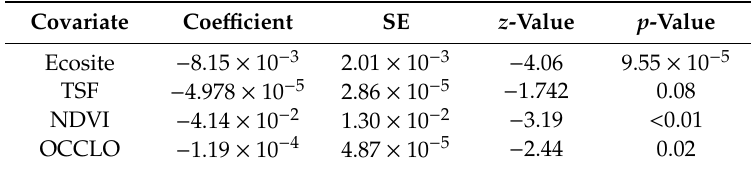
Table A6. Model summary for the model used to create the canopy closure layer for modelling lichen presence and abundance. TSF = time-since-fire, NDVI = normalized di ff erence vegetation index, OCCLO = canopy closure derived from the forest inventory datasets. SE = standard